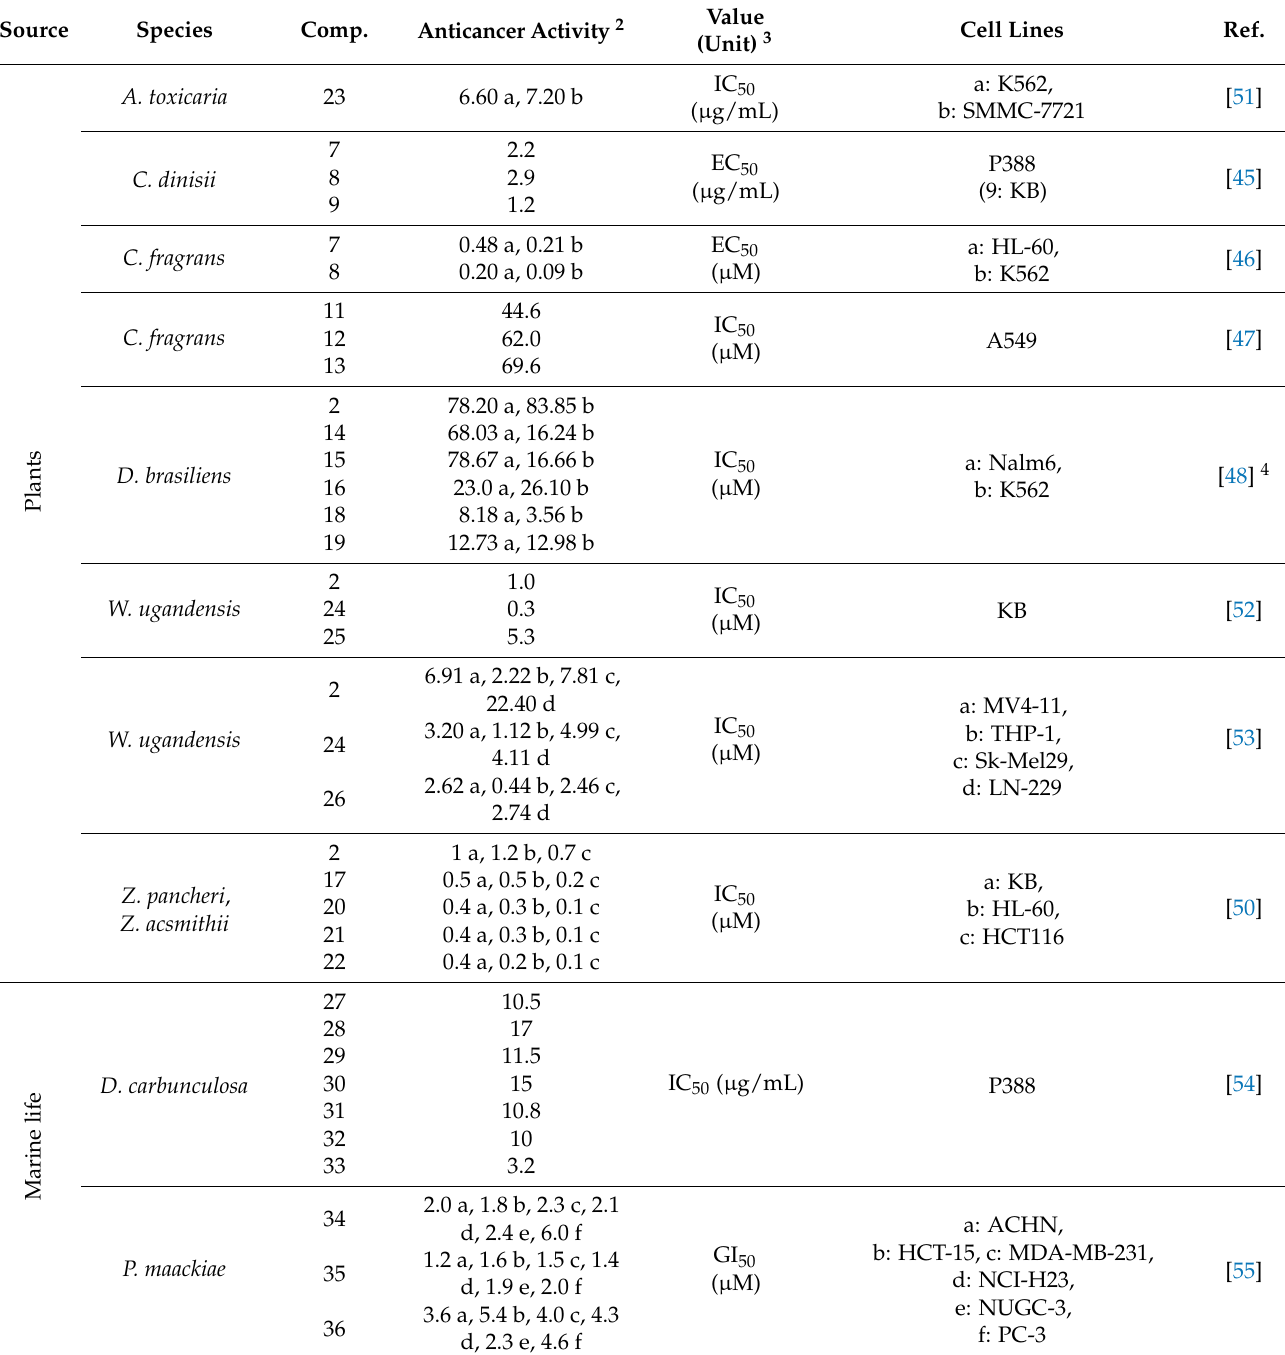
Table 1. Anticancer activity of natural drimane and coloratane sesquiterpenoids 1